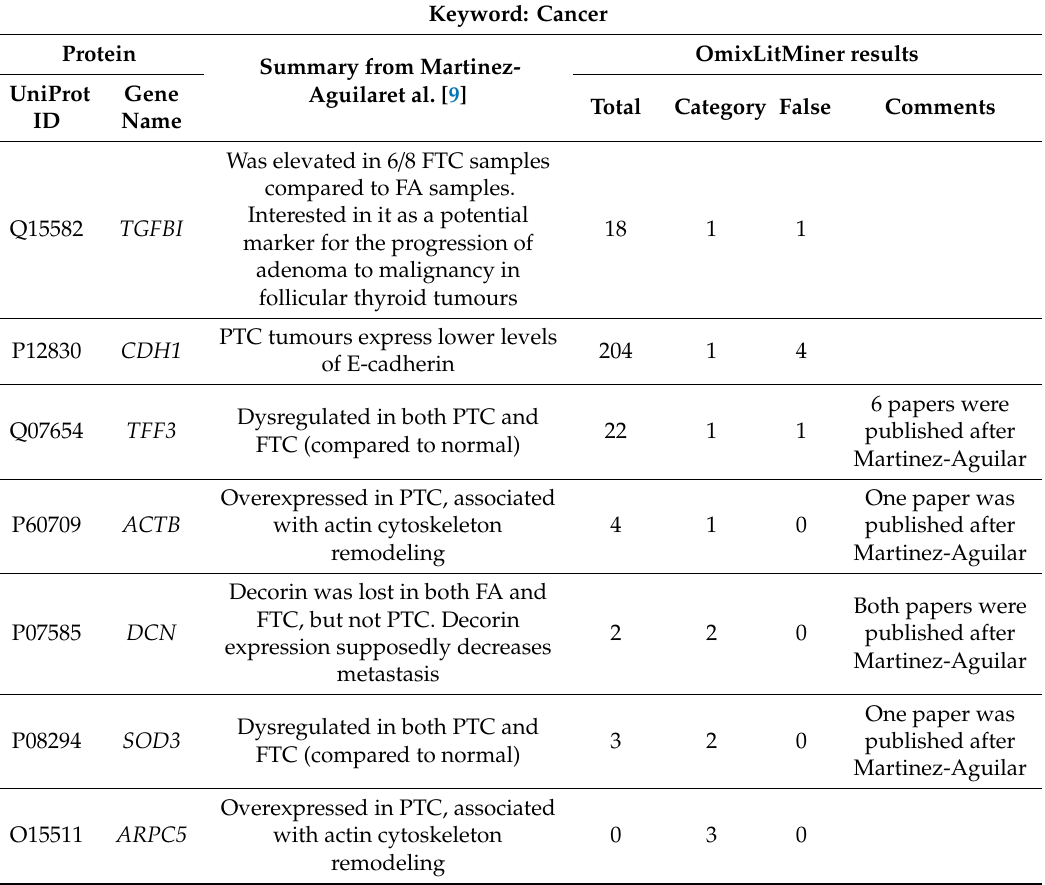
Table 1. Extract of the OmixLitMiner output of the three comparisons found in the supplement of Martinez-Aguilar et al. [9] using the keyword